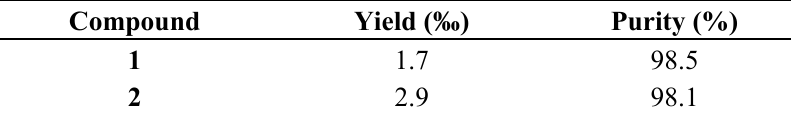
Table 3. The yields and purity of compounds 1 – 2